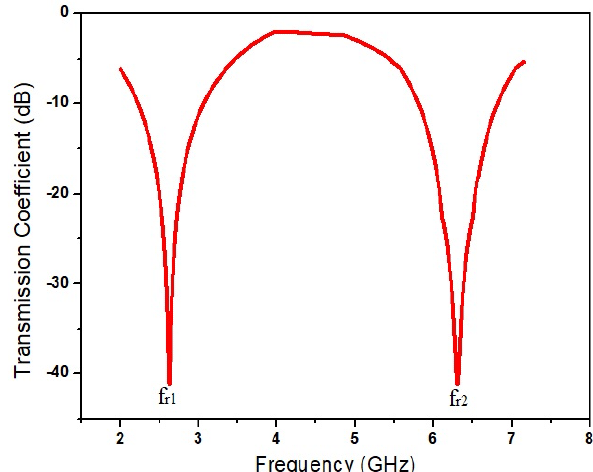
FIGURE 4: Frequency response of the DSLFSS depicting resonant